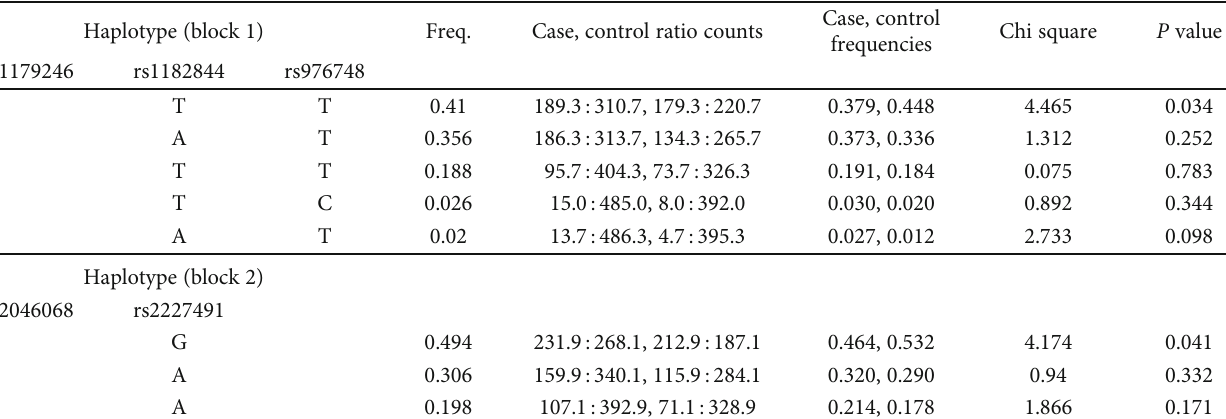
Table 6: Haplotypes of IL-22 gene when control group was compared to patients ’